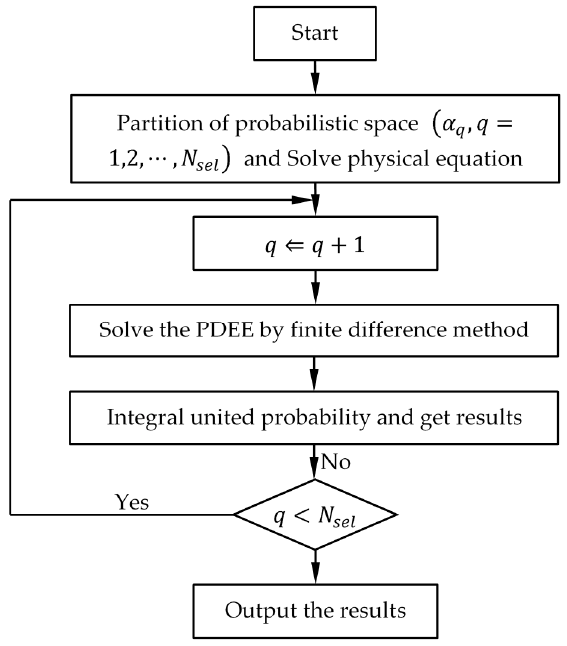
Figure 6. Computational process of PDEM.